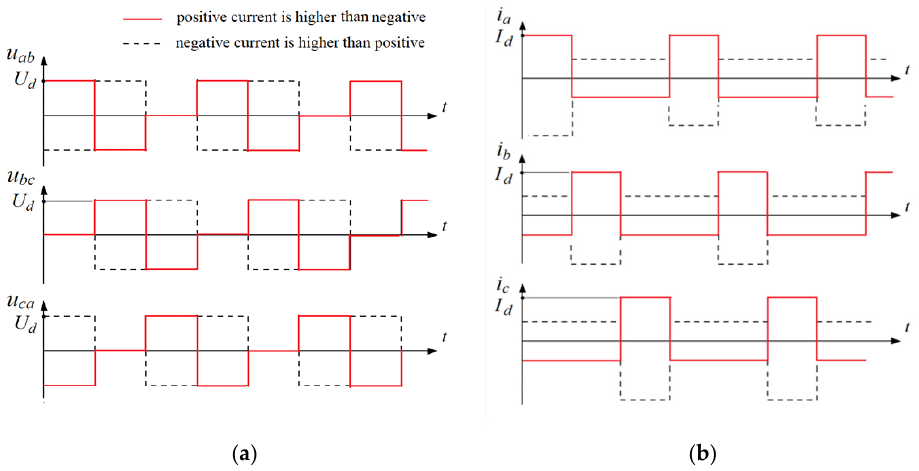
Figure 3. Expected curves of: ( a ) Voltages and ( b ) Currents, during switching period, where u ab , u bc , u ca —line-to-line voltages; i a , i b , i c —conductor currents.